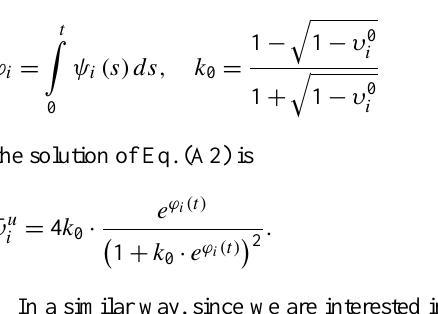
Fig. A1. Comparison of υ i , υ u of parameters: m i = 25000kg, ρ = 1000kgm − 3 , c d 0 . 025s, k s = 35 1